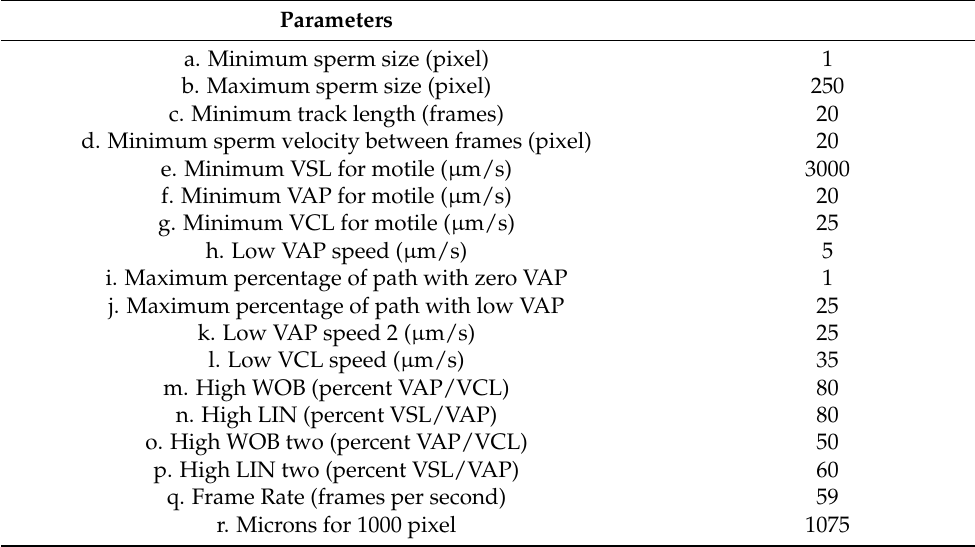
Table 3. Optimal values entered in the CASA plugin to correctly analyze the different movement parameters of human